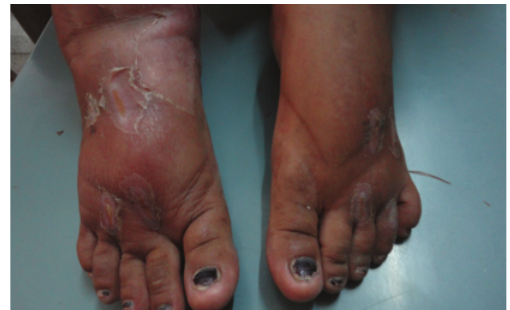
Figure 4: Trichotillomania lesions on vertex of